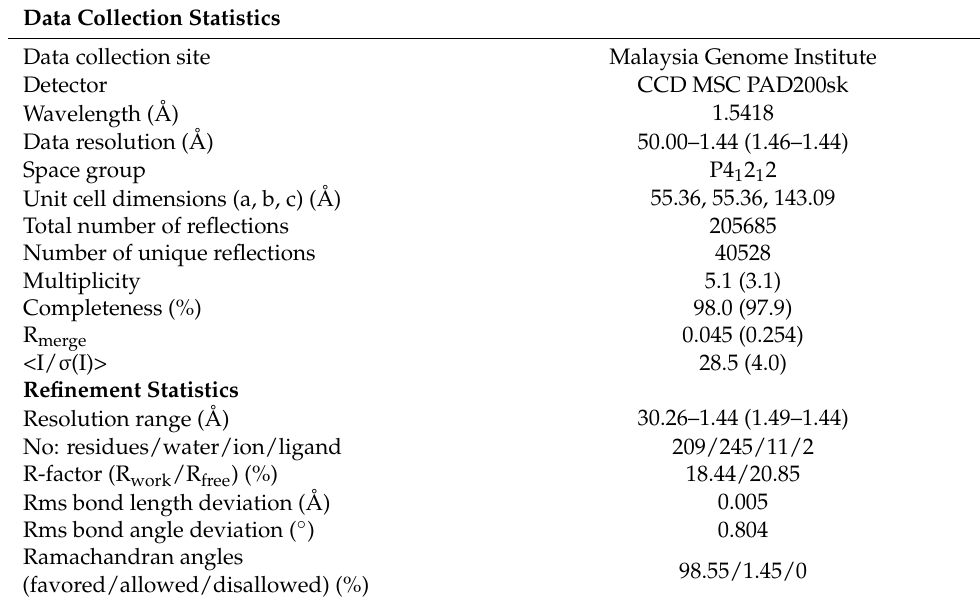
Table 2. Statistics of BLEG-1 crystallographic structure